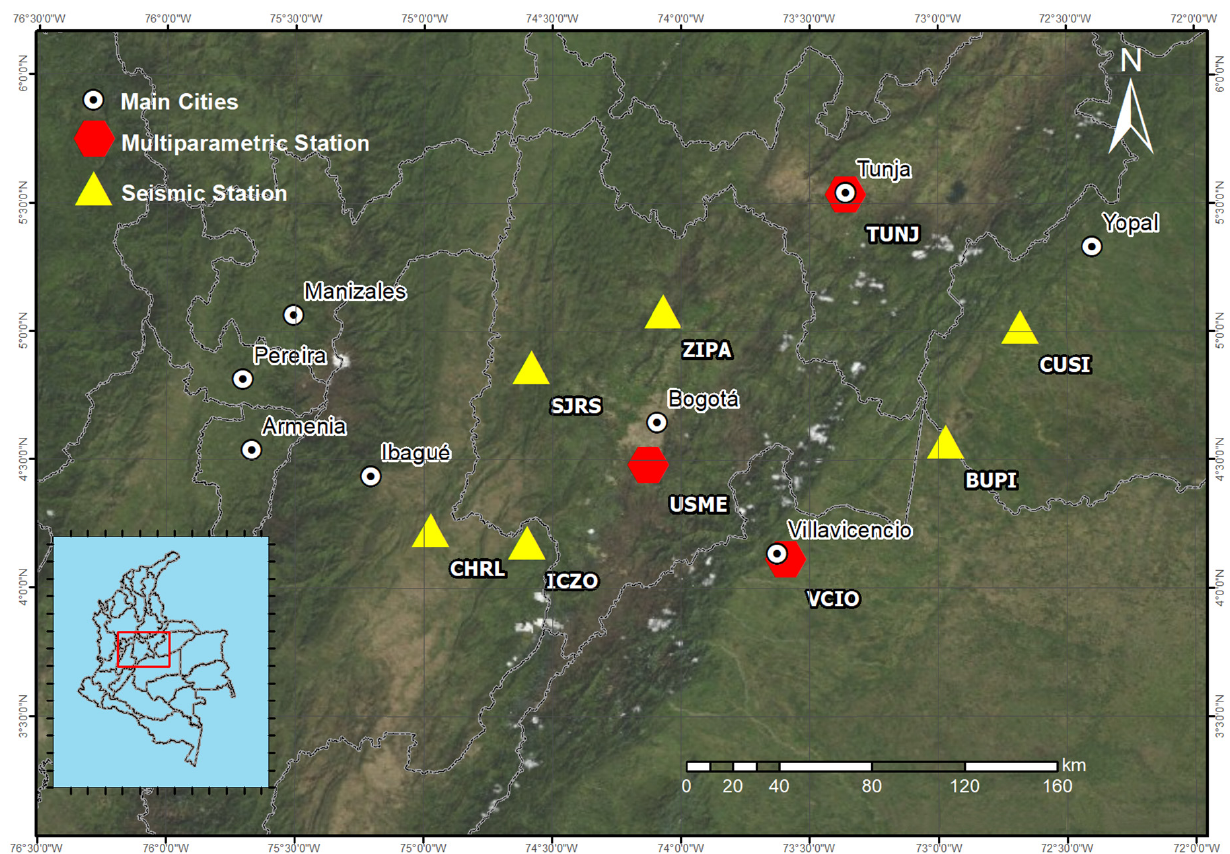
Figure 1. Distribution of the stations of the Geophysical Network of the National University of Colombia in the central region of